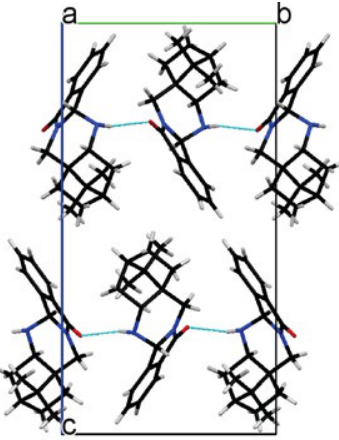
Figure 5. Mercury 29 drawing of molecular packing in 6 . Light blue lines show intermolecular N-H…O hydrogen bonds.